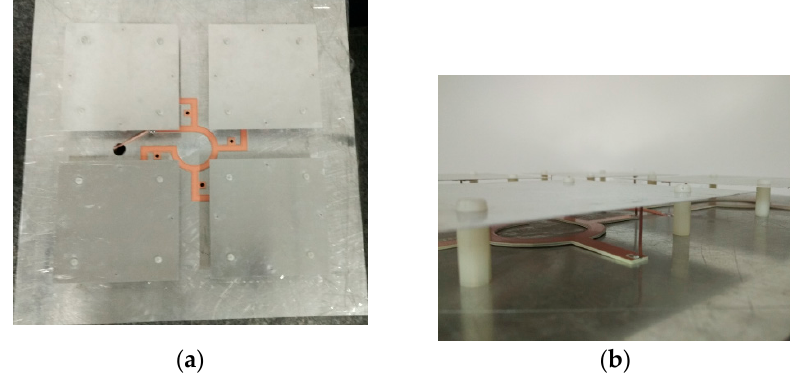
Figure 7. Manufactured antenna prototype: ( a ) top view and ( b ) side view.